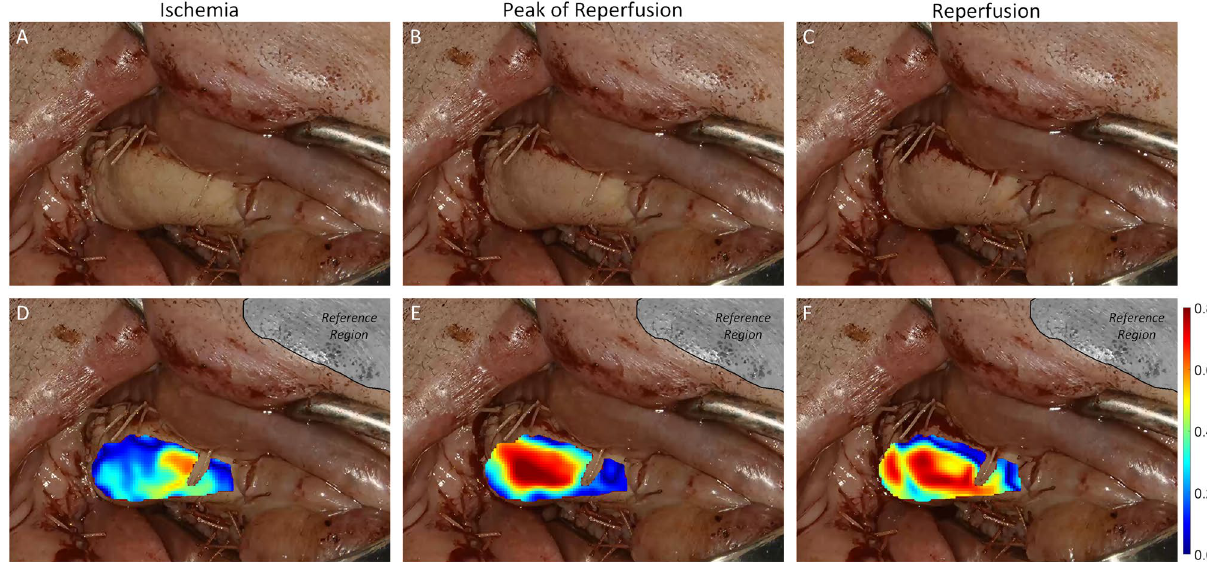
Fig. 1C top row, the magnitude M is visualized at four specific time points: before and after clamping arteria at the donor side and before and after reperfusion at the final location in the oral cavity. In Fig. 2, the visualization of ρ (D–F) is shown in comparison to the standard RGB view (A–C) at three specific time points during reperfusion. The common RGB view of the surgeon (top row) is augmented with a ‘heat map’ showing the local rPPG correlation behavior over time. Thus, critical perfusion is locally and con- tinuously detectable. In some small areas, within the ROI, short and small (frame-wise) abrupt changes of the heat map may occur. These changes can be caused by a strong noise component within the rPPG signal of the corresponding spatial position. However, long-time (over seconds) development of perfusion becomes visible for the surgeon intraoperatively. It is possible to visualize all three analyzed parameters, e.g., the magnitude is selected for visualization in Fig. 1C. The visualization of the continuous perfusion behavior is shown in Movie S1 in the supplemental material. At the beginning, PI and rPPG correlation ρ are low (colored from blue to greenish). At the time of reperfusion, PI shows its characteristic peak (in red) and at the same time, the correlation ρ starts to increase (becoming red over the entire flap) showing continuous perfusion.